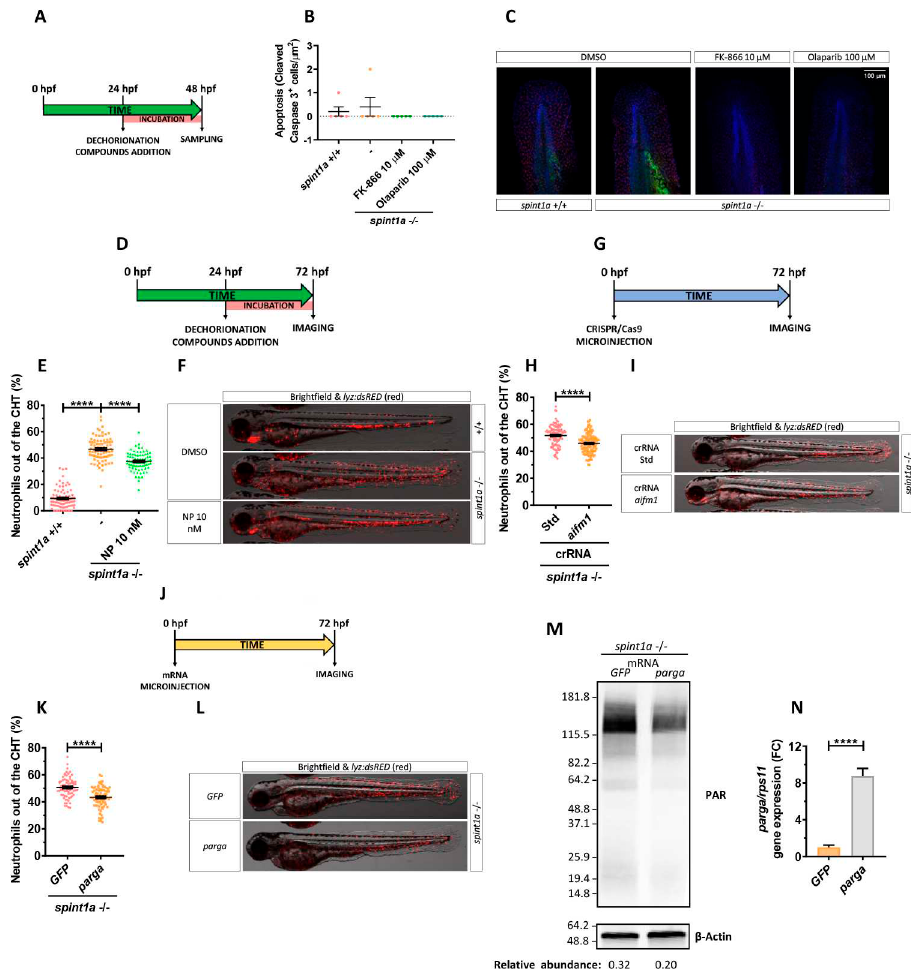
Fig 5. Inhibition of parthanatos rescues skin inflammation of Spint1a-deficient larvae. (A, B) Quantification of cleaved caspase 3 positive cells from 48 hpf wild-type and Spint1a-deficient larvae treated for 24 hours with 10 μ M FK- 866 or 100 μ M olaparib. (C) Representative merge images of maximum intensity projection of an apotome Z stack from zebrafish larvae of every group are shown. WIHC with anti-cleaved Casp3 (green) and anti-P63 (basal keratinocyte marker, red) were counterstained with DAPI (blue). (D–N) Pharmacological and genetic inhibition experimental settings (D, G, J). Quantification of the percentage of neutrophils out of the CHT in embryos treated with 10 nM NP (Aifm1 translocation inhibitor) (E), aifm1 genetic inhibition (H) and parga mRNA overexpression (K). Representative merge images (brightfield and red channels) of lyz : dsRED zebrafish larvae of every group are shown (F, I, L). For mRNA overexpression, 1-cell stage zebrafish eggs were microinjected, and imaging was performed in 3dpf larvae (J). Western blots with anti-PAR and anti- β -actin of tail fold lysates from 3 dpf wild-type and Spint1a-deficient zebrafish larvae microinjected with parga or GFP mRNA. The relative abundance of PAR with respect to β -actin is shown in each lane (M). Relative mRNA levels of 3 dpf wild-type zebrafish larvae microinjected with parga or GFP mRNA (N). Each dot represents one individual, and the mean ± SEM for each group is also shown. p -Values were calculated using 1-way ANOVA and Tukey multiple range test and t test. ���� p � 0.0001. The data underlying this figure can be found in S1 Data. ANOVA, analysis of variance; CHT, caudal hematopoietic tissue; NP, N-